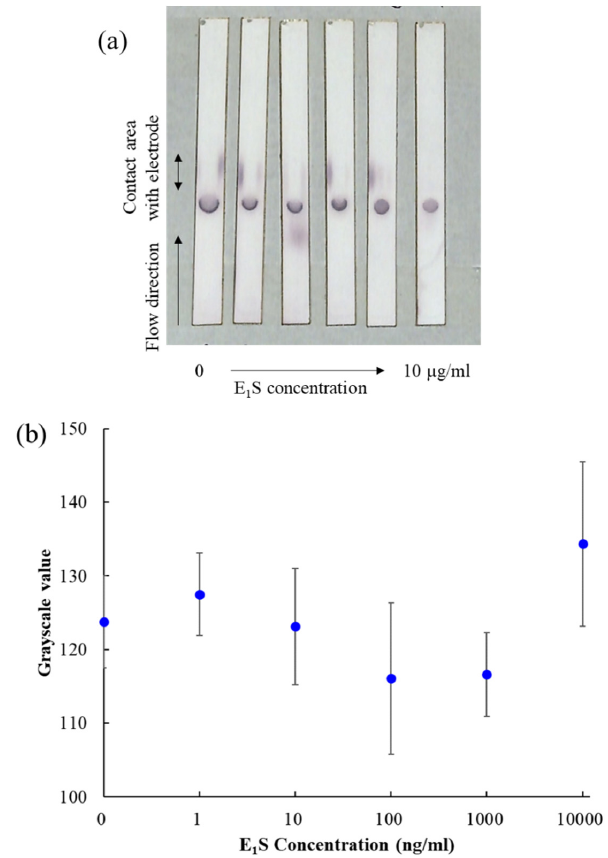
Figure 5. Results of colorimetric method. ( a ) Photograph of a colored nitrocellulose membrane after being used for electrochemical immunochromatography. ( b ) The average 8-bit grayscale value for the antibody-immobilized area at each E 1 S concentration (n = 3). The grayscale value was calculated using Adobe